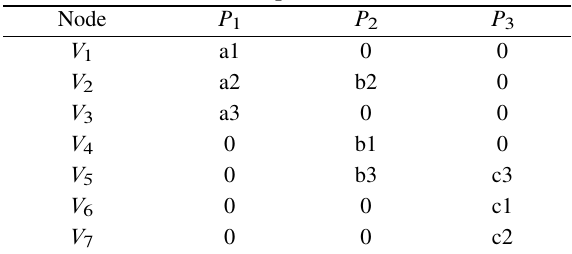
Fig. 10 Example of join [17]